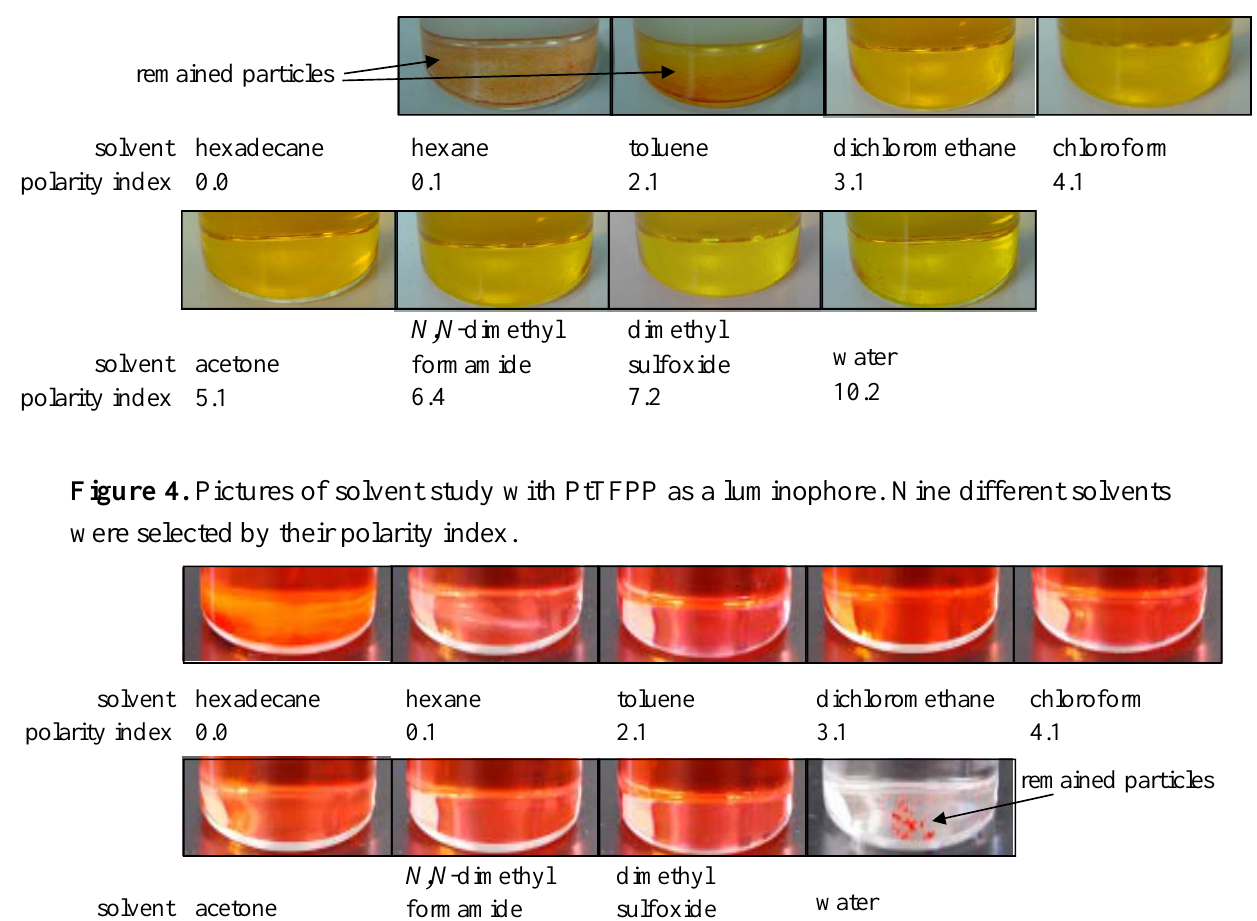
Figure 3. Pictures of various luminophore solutions with bathophen ruthenium as a luminophore. Eight solvents were selected based on their polarity index.